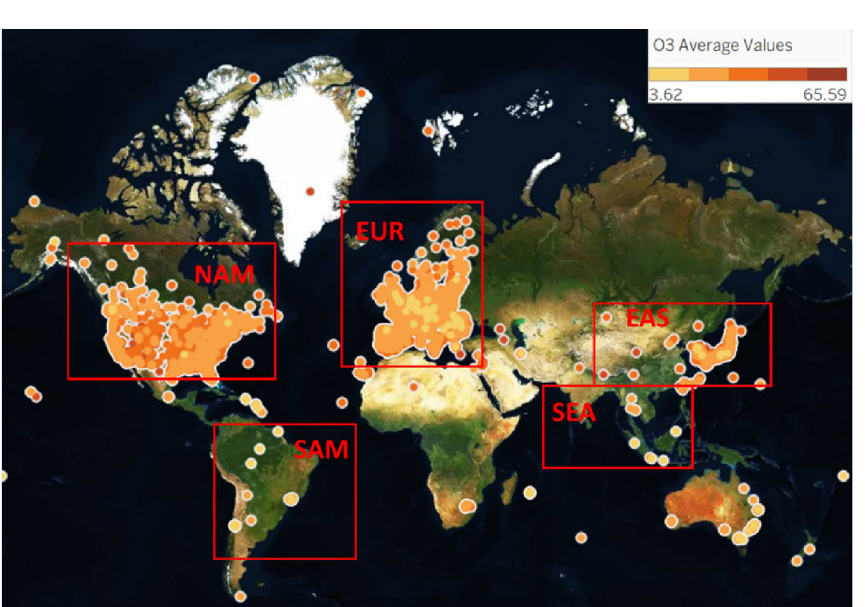
Figure 3. Global distribution of monitoring